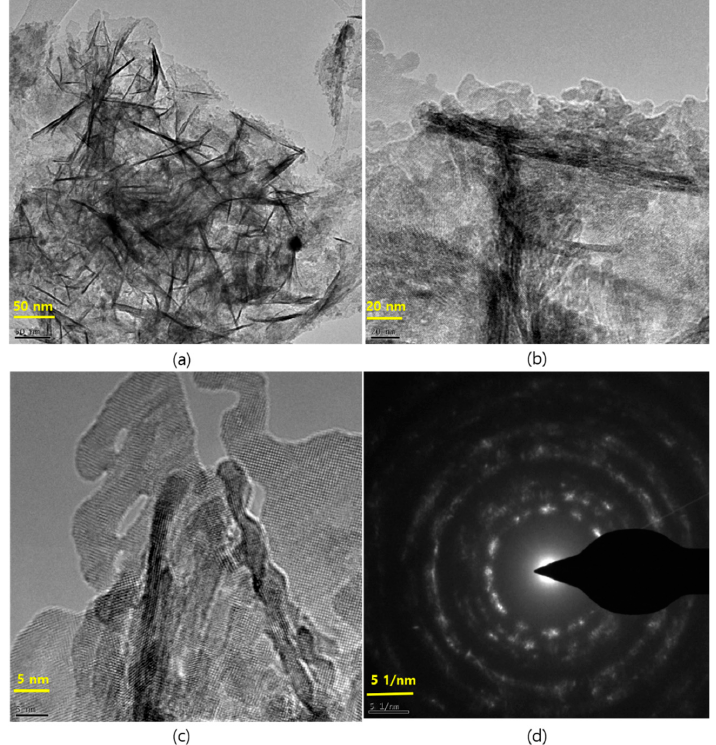
Figure 3. TEM images at di ff erent magnification of the Ag QDs / SnO 2 nanostructures and their selected area electron di ff raction (SAED) pattern. ( a ) Ag QDs / SnO 2 nanostructures at 50 nm; ( b ) Ag QDs / SnO 2 nanostructures at 20 nm; ( c ) High resolution image Ag QDs / SnO 2 nanostructures at 5 nm; ( d ) SAED pattern of Ag QDs / SnO 2